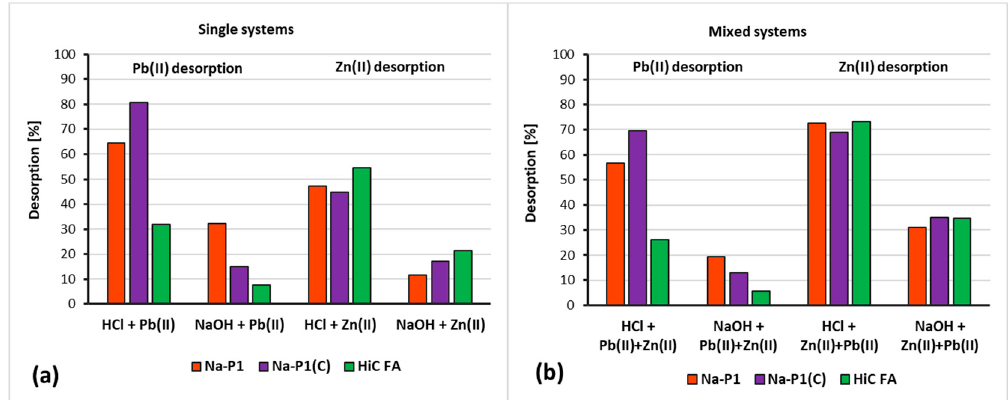
Figure 13. Desorption (%) of Zn(II) and Pb(II) ions from the HiC FA, Na-P1 and Na-P1(C) surfaces in single ( a ) and mixed ( b ) systems using 0.1 M HCl or 0.1 M NaOH.